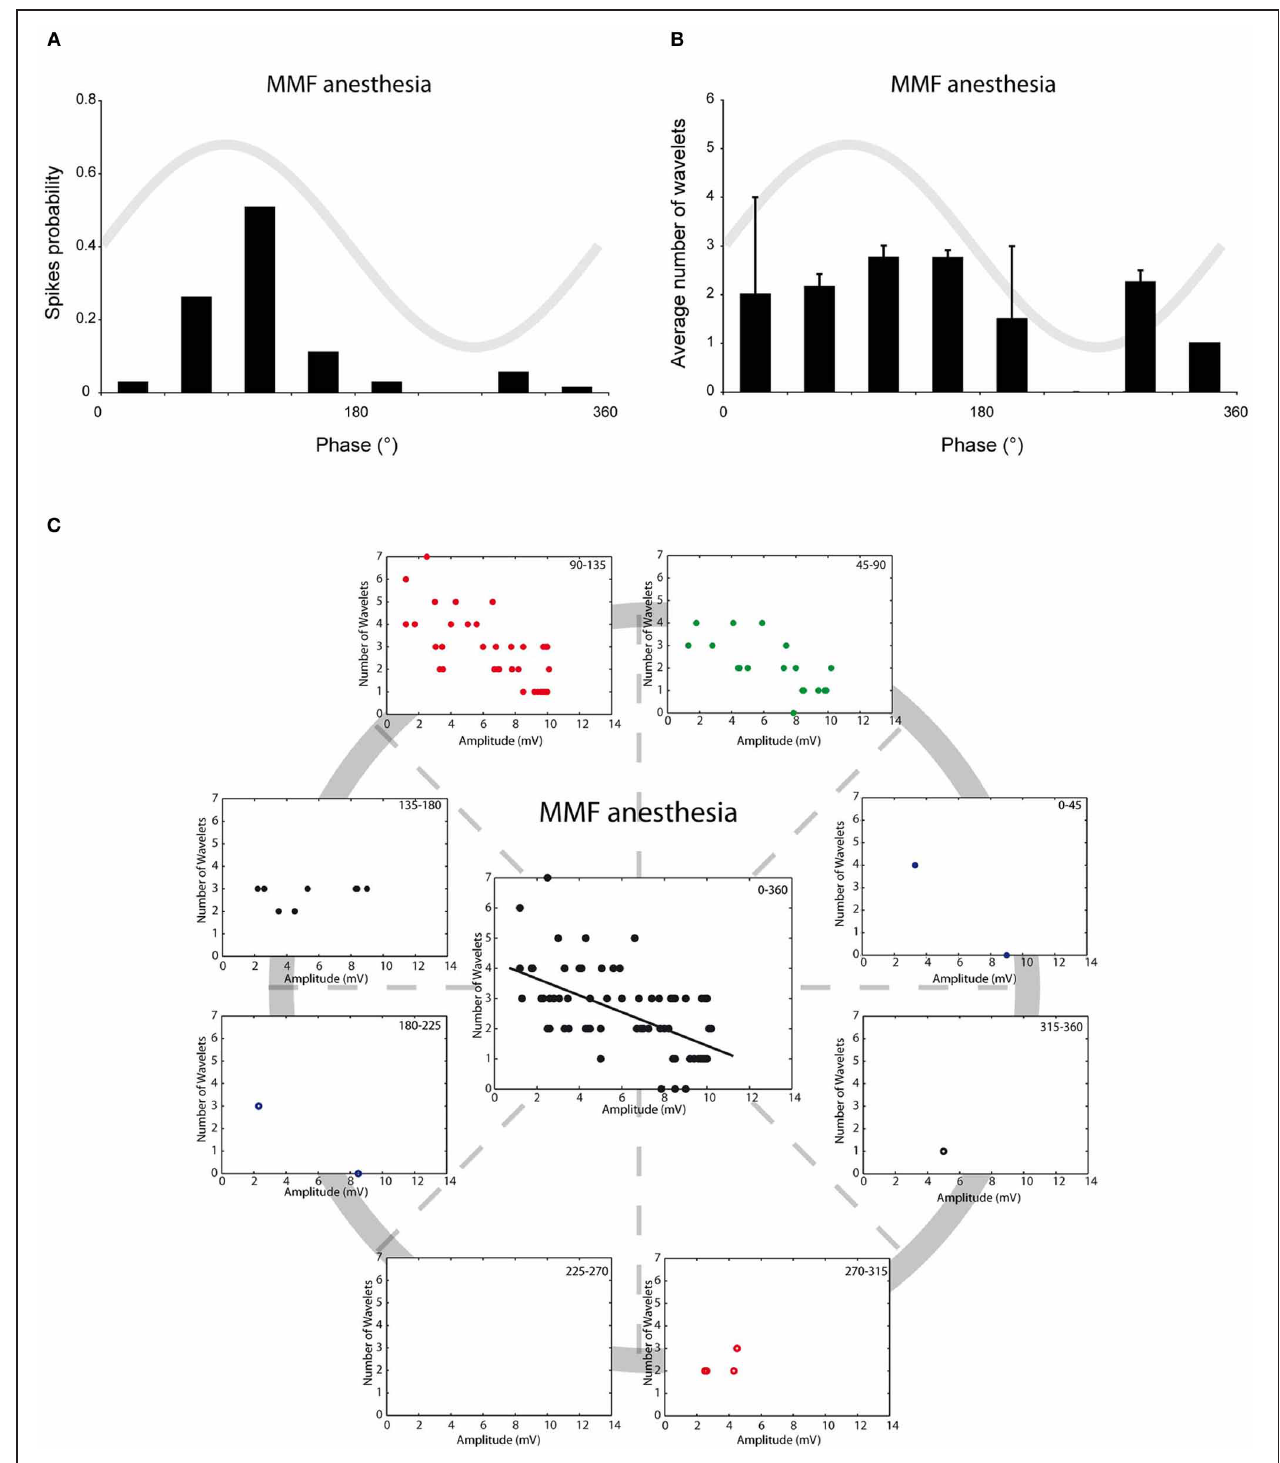
FIGURE 3 | Burst size of olivary wavelets and SSTOs under MMF anaesthesia. (A) The occurrence of spontaneous spikes (spike probability) in relation to the phase of the SSTO obtained from olivary neurons recorded under MMF anaesthesia ( n = 73). (B) Average number of wavelets on the ADP of spontaneous spikes in relation to the phase of the SSTO obtained from olivary neurons recorded under MMF anaesthesia ( n = 73).